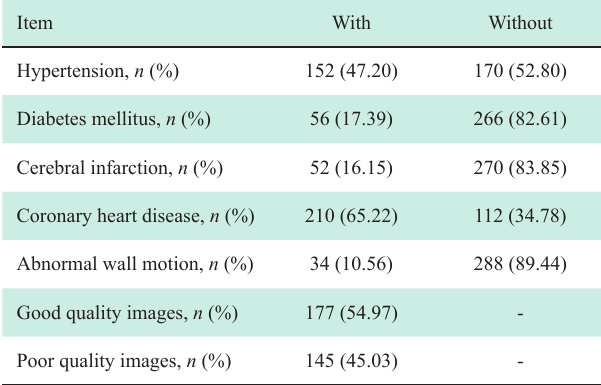
Table 1 Baseline characteristics of study participants ( n = 322)